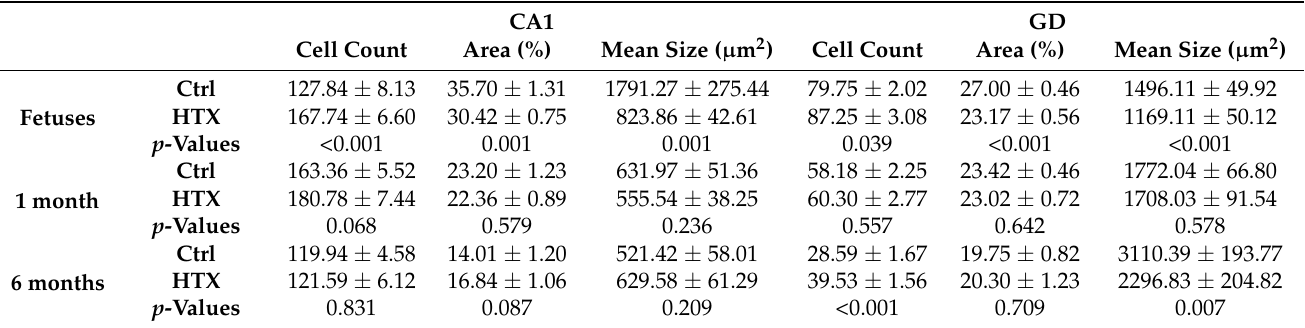
Table 5. Effect of maternal supplementation with HTX on NeuN immunostaining in the hippocampus of control (Ctrl) and HTX-treated pigs. ImageJ was used for the quantification (mean ±